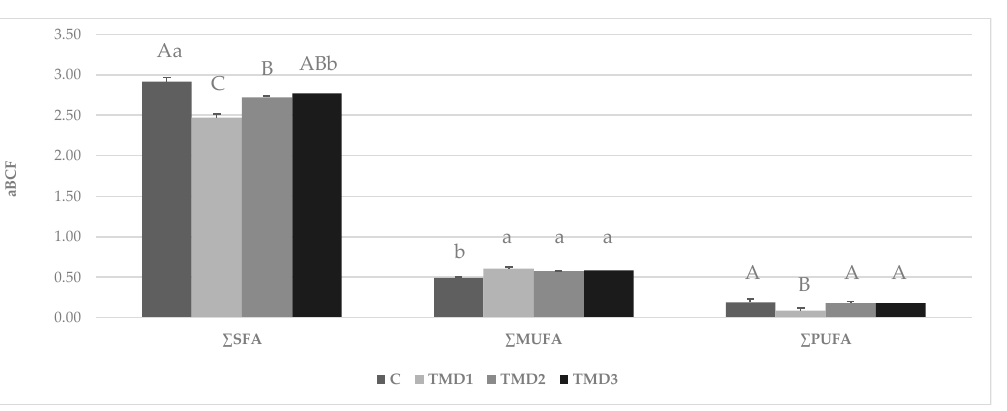
Figure 1. Effect of the diet on the apparent bioconcentration factors for the total identified saturated fatty acids (SFA), monounsaturated fatty acids (MUFA), and polyunsaturated fatty acids (PUFA) in the control (C) and experimental diets (TMD1: high-nonfiber carbohydrate content total mixed diet; TMD2: high-fiber content total mixed diet; TMD3: high-protein content total mixed diet). A,B,C capital letters above the means indicate a significant difference at p < 0.01; a,b letters above means indicate a significant difference at p < 0.05.